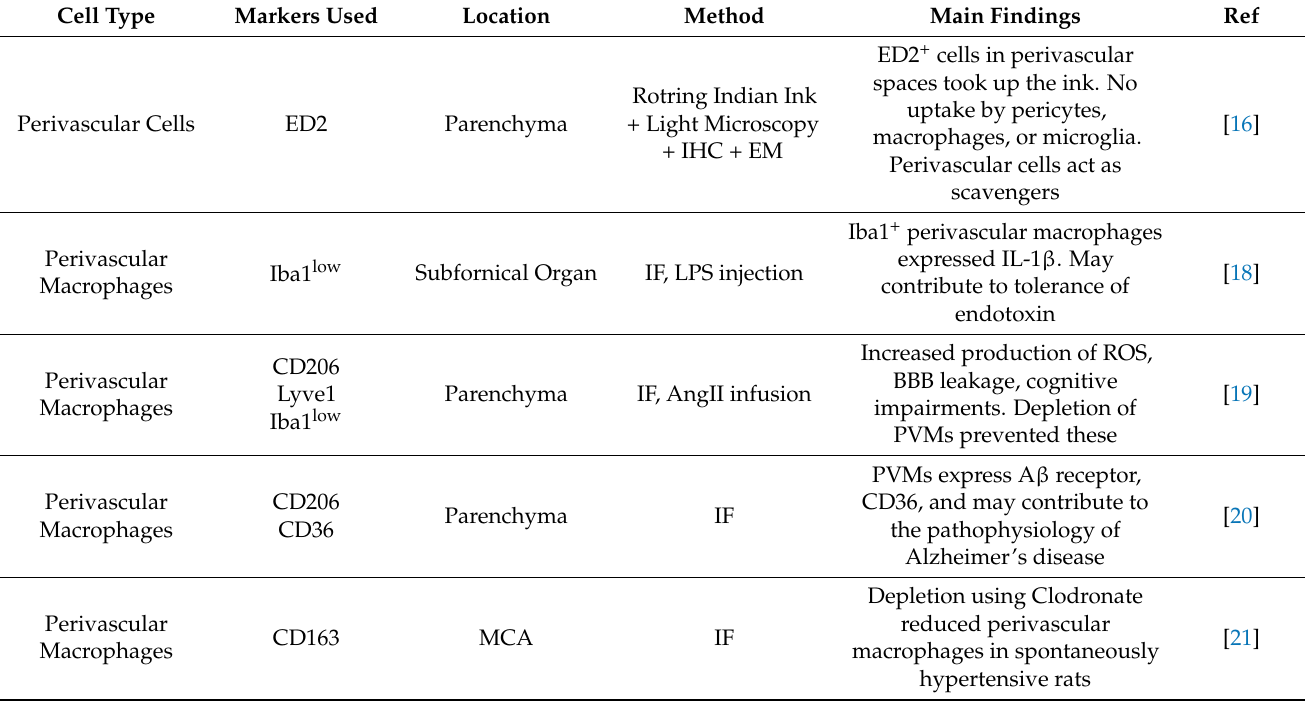
Table 2. Characteristics of different perivascular